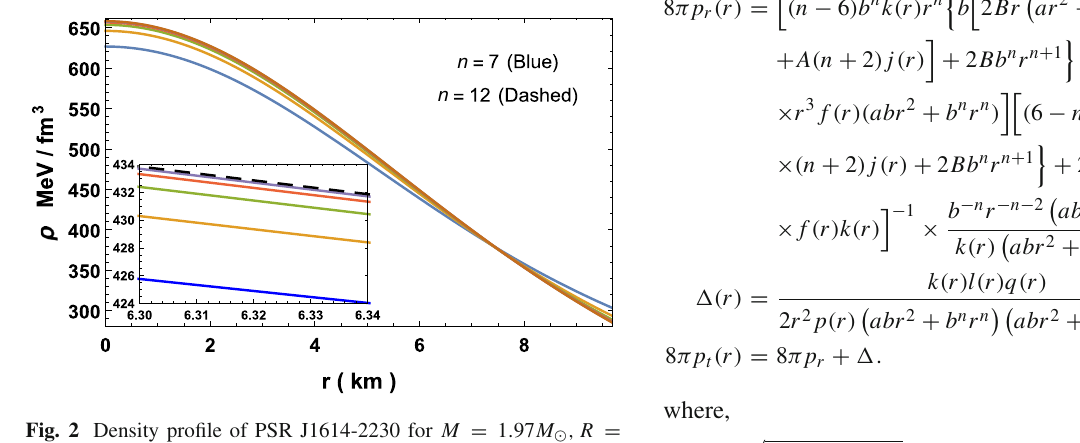
Fig. 2 Density profile of PSR J1614-2230 for M = 1 . 97 M (cid:6) , R = 9 . 69 km and b = 0 . 04